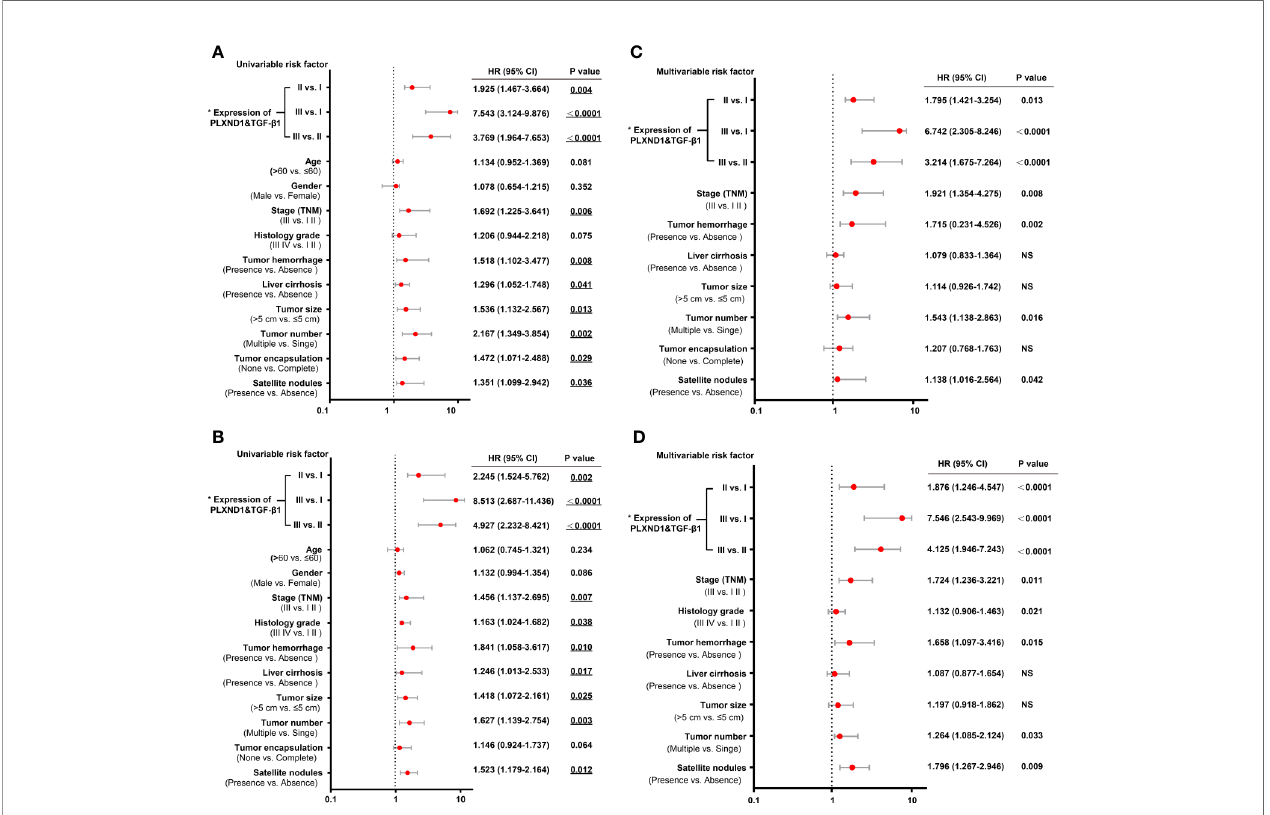
FIGURE 5 | Univariate and multivariate analyses of prognostic factors with overall survival (OS) and recurrence-free survival (RFS) in hepatocellular carcinoma (HCC) patients. (A) The univariate analyses of prognostic factors with patient overall survival (OS) are presented in the forest plot. (B) The univariate analyses of prognostic factors with patient recurrence-free survival (RFS) are presented in the forest plot. (C) The multivariate analyses of prognostic factors with patient OS are presented in the forest plot. (D) The multivariate analyses of prognostic factors with patient RFS are presented in the forest plot. The expression of PLXND1 & TGF- b 1 are indicated as follows: I, PLXND1 low /TGF- b 1 low ; II, PLXND1 high /TGF- b 1 low and PLXND1 low /TGF- b 1 high ; and III, PLXND1 high /TGF- b 1 high